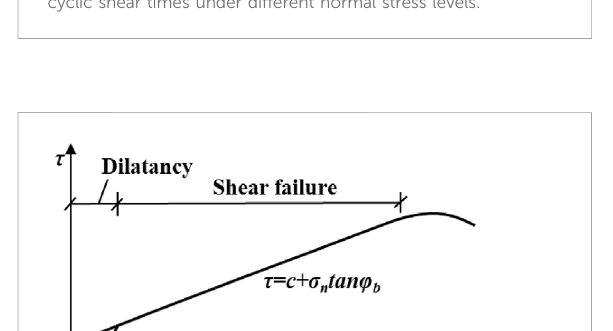
FIGURE 6 Change in shear strength ratio of the structural plane with cyclic shear times under different normal stress levels.